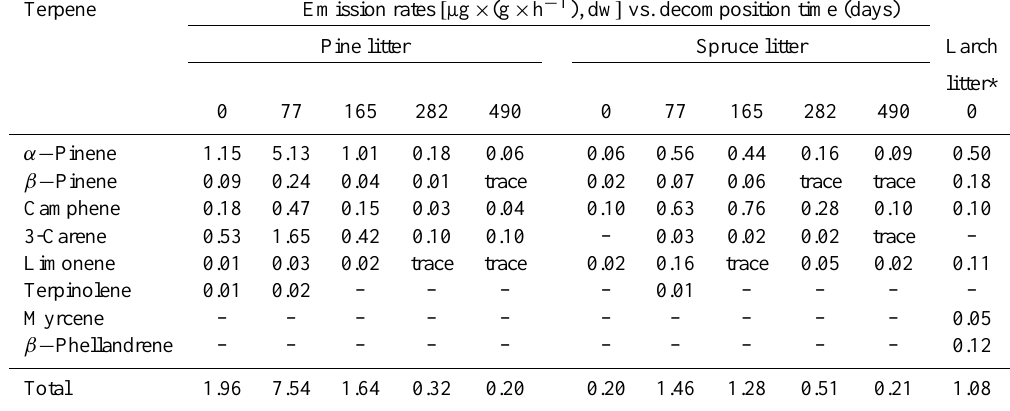
Table 1. Emission rate of monoterpene hydrocarbons from leaf litter of Scots pine and Norway spruce (20 ◦ C).